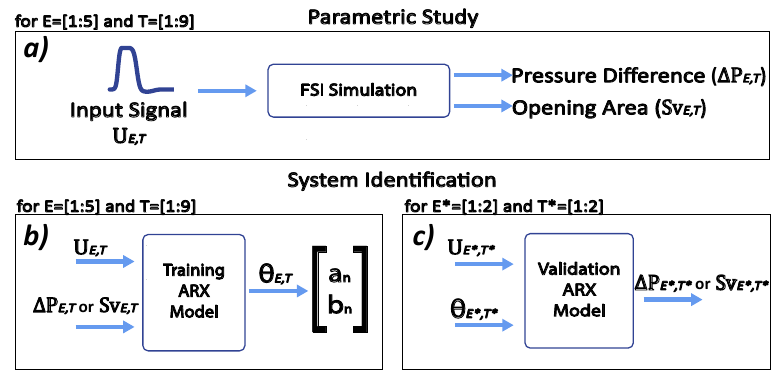
Figure 3. ( a ) The parametric study is summarized as a for loop of five variations in E and nine in T . ( b ) The system identification process uses the input/outputs signals to obtain forty-five θ vectors. ( c ) The validation process simulates the output from new input signals for E ∗ and T ∗ representing the elastic modulus and periods that were not initially considered in the parametric